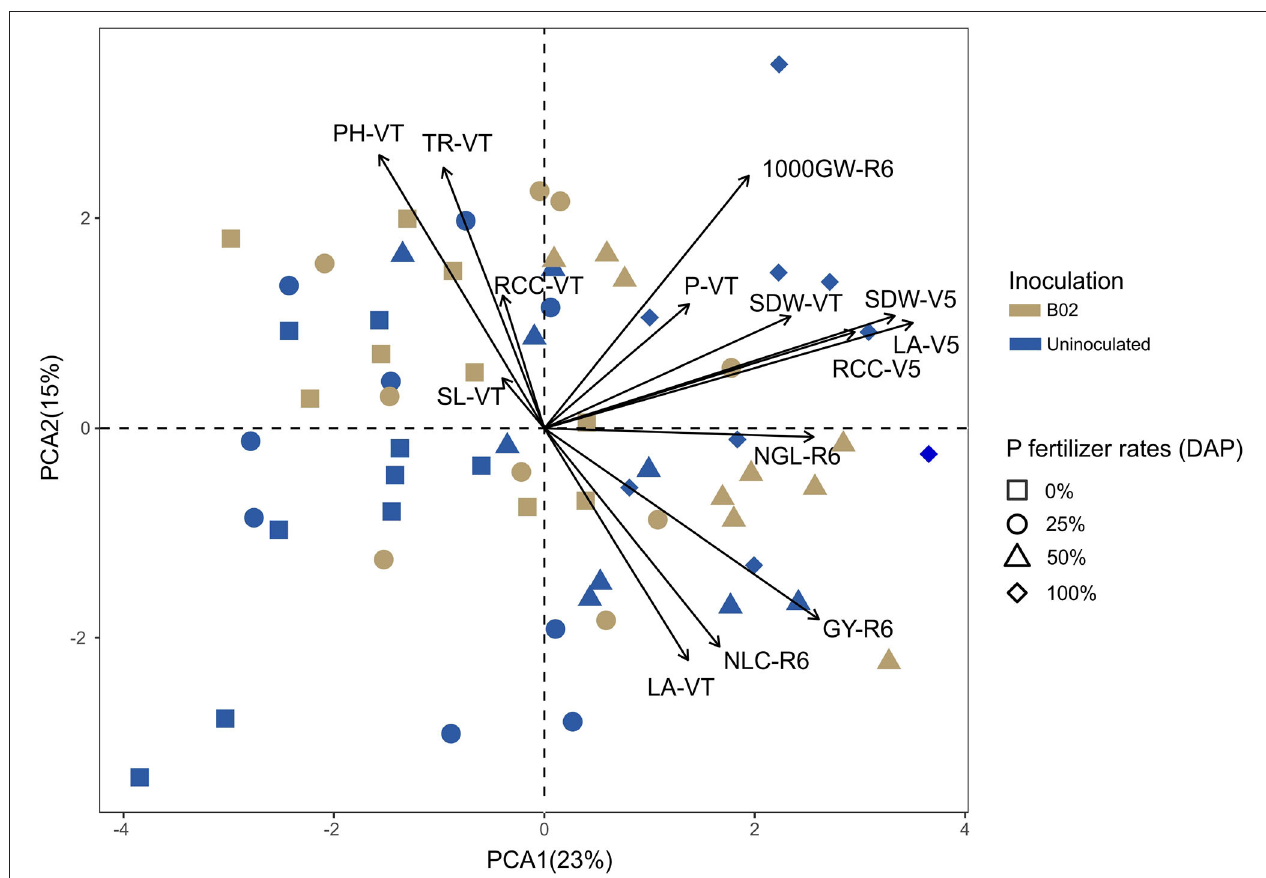
FIGURE 4 | Principal component analysis plot correlating morphometric, physiological, and productivity parameters promoted by inoculation with Rhizobium sp. B02 in the white endosperm genotype of maize. SDW, shoot dry weight; LA, leaf area; RCC, relative chlorophyll content; SL, shoot length; P, shoot P content; PH, photosynthetic rate; TR, transpiration rate; NLC, number of lines per cob; NGL, number of grains per line; 1,000 GW, 1,000-grain weight; GY, grain yield; V5, vegetative stage of the tillering; VT, vegetative state of the tassel; R6, reproductive stage of physiological